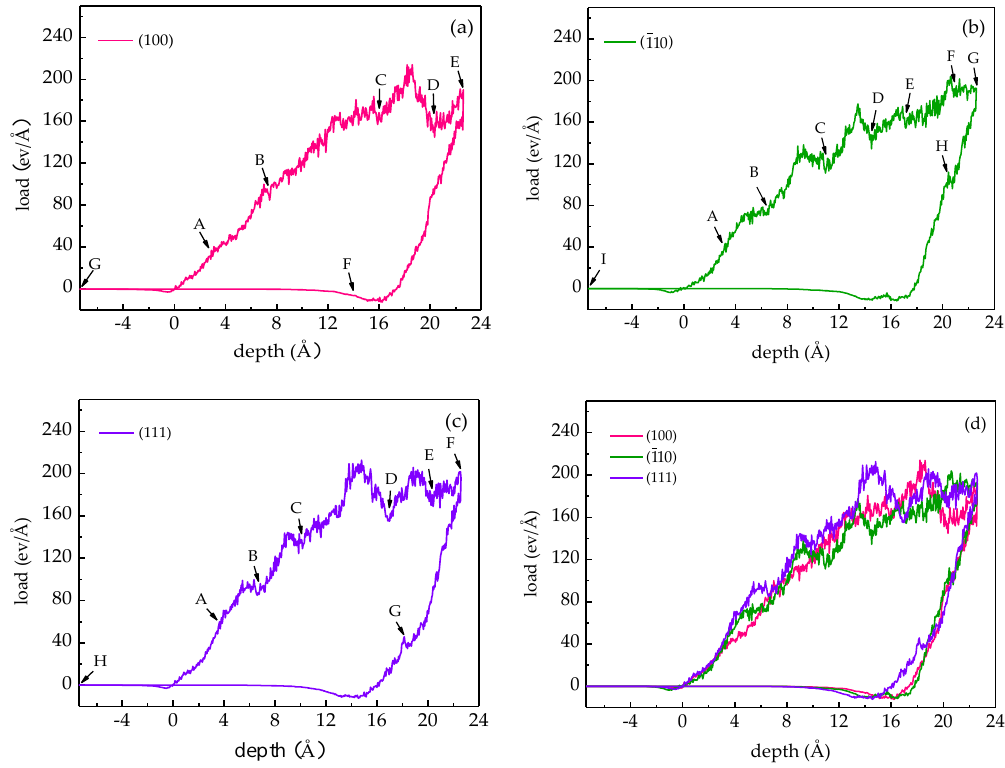
Figure 3. Load-depth curve of ( a ) the (100) sample, ( b ) the (110) sample and the ( c ) (111) sample; ( d ) shows the load-depth curves of the three different samples. The letters labeled in ( a – c ) represent the characteristic points, and the defect evolution at these points will be described in Section